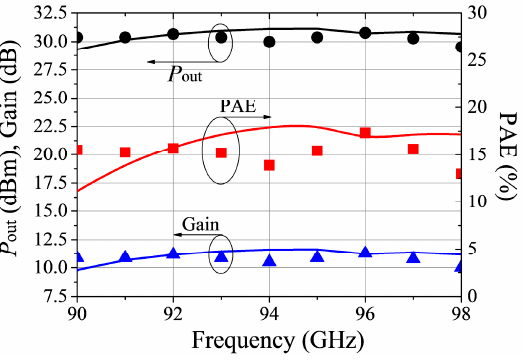
Figure 17. Measured (Symbol) and simulated (solid) large-signal characteristics of the W-band MMIC PA.